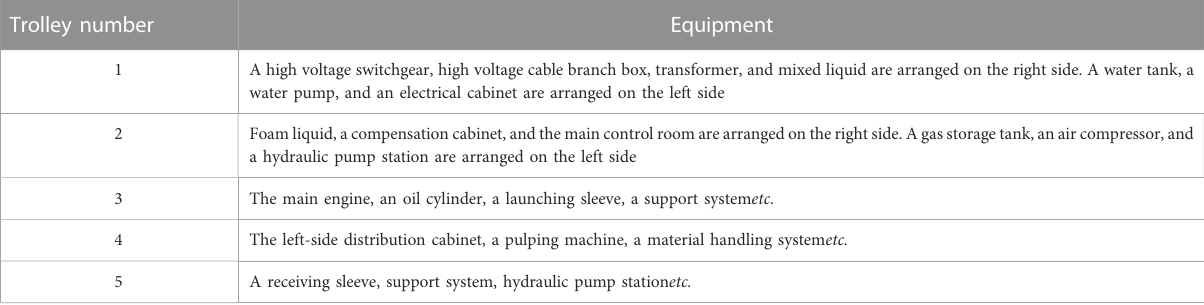
TABLE 2 Comparison table of vehicles and